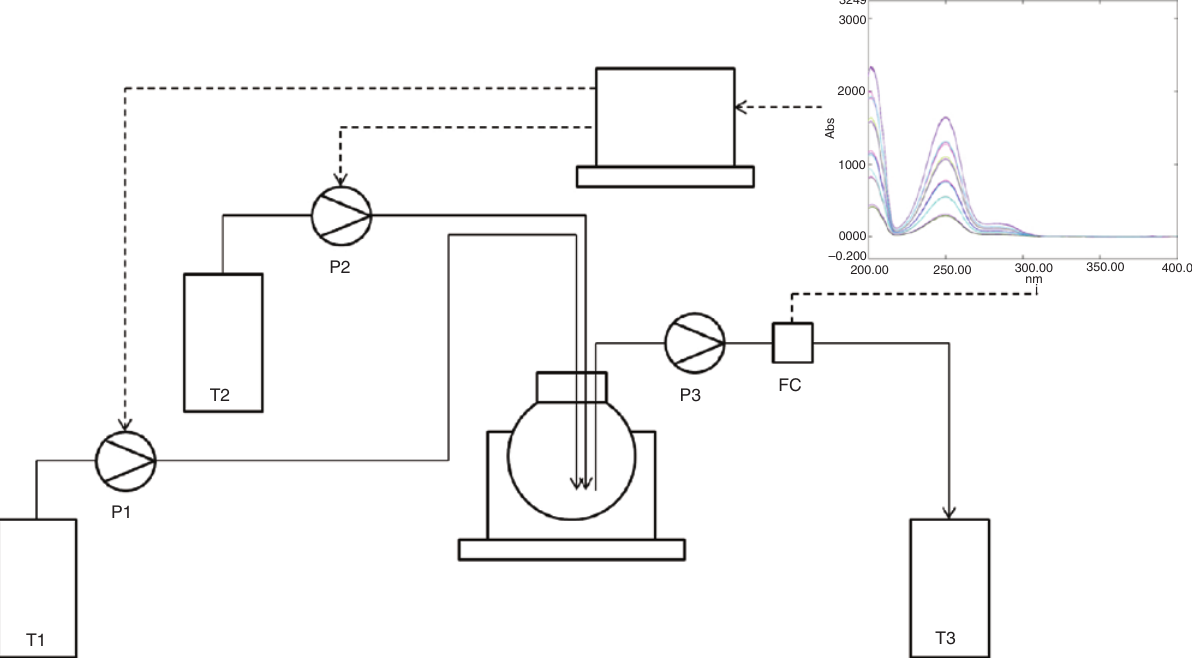
Figure 5: Experimental setup for performing the chemical reaction between tris(hydroxymethyl)aminomethane (TRIS) and benzaldehyde in a batch reactor with on-line ultraviolet-visible (UV-VIS) real time process monitoring. Process flow sheet including: T1, T2, T3 – storage tanks; P1, P2 and P3 – pumps; T – thermometer, FC – flow cell. See text for an explanation of the operation of the